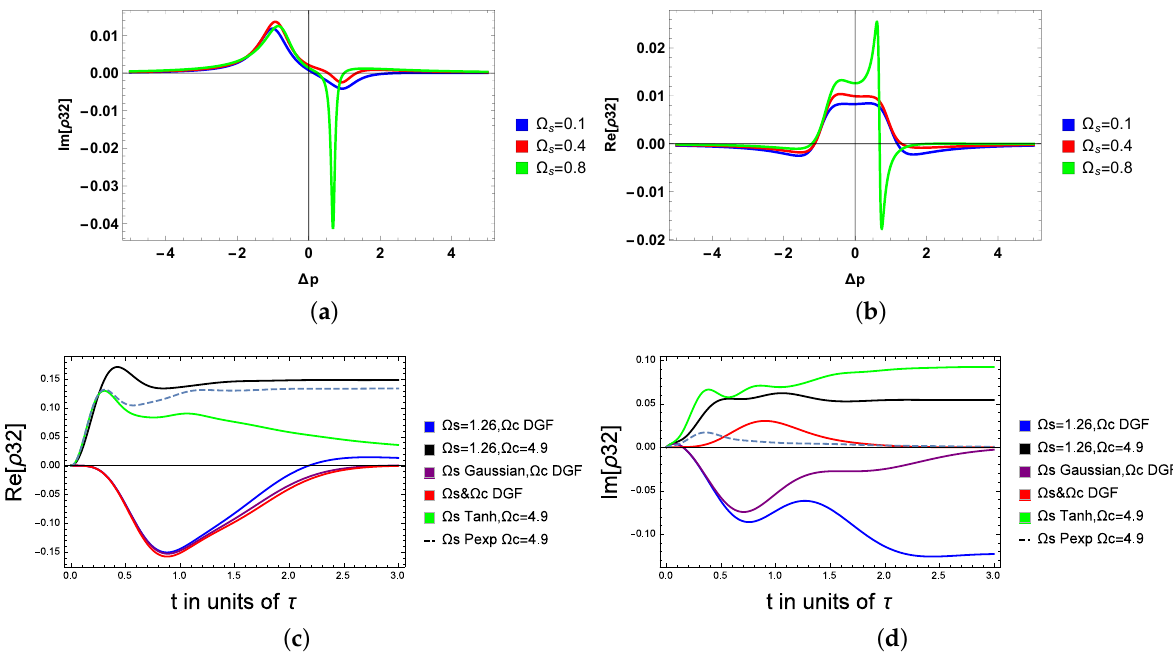
Figure 4. The generated coherence between the excited and the intermediate state: ( a , b ) for variable amplitude of the microwave field, ( c , d ) for shaped microwave